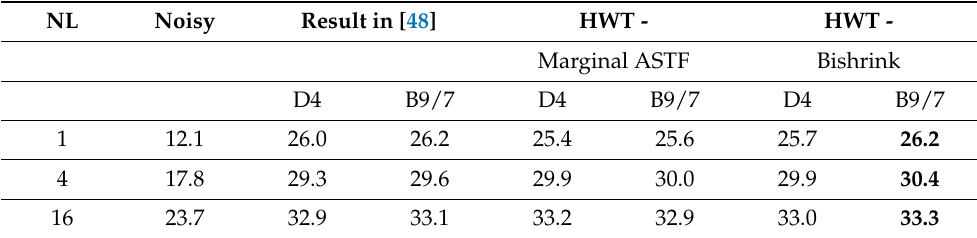
Table 4. Image Lena. PSNR [dB] performance of different wavelet-based despeckling systems: proposed in [48]; the association of HWT with a marginal ASTF [58]; the association of HWT with Bishrink filter, obtained using two different MWs: Daubechies 4 (D4) and Biorthogonal Daubechies 9/7 (B9/7).